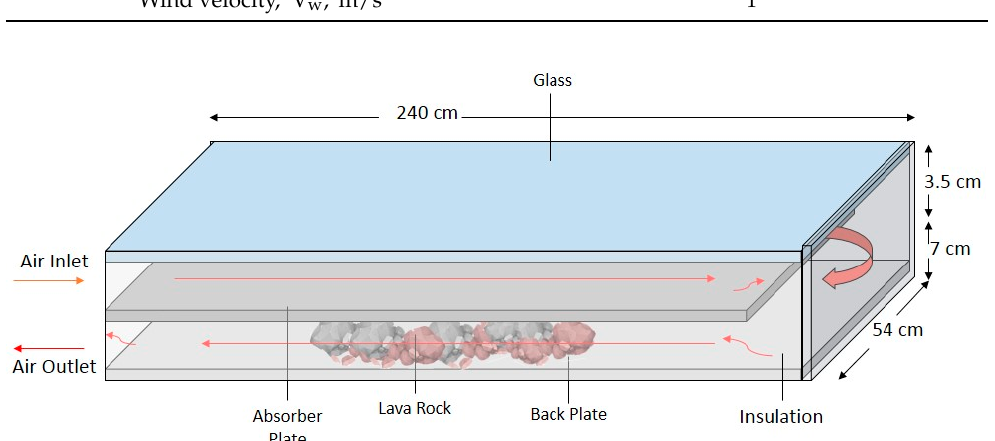
Figure 2. Cross-section of double pass solar air heater (DPSAH) with lava rock.